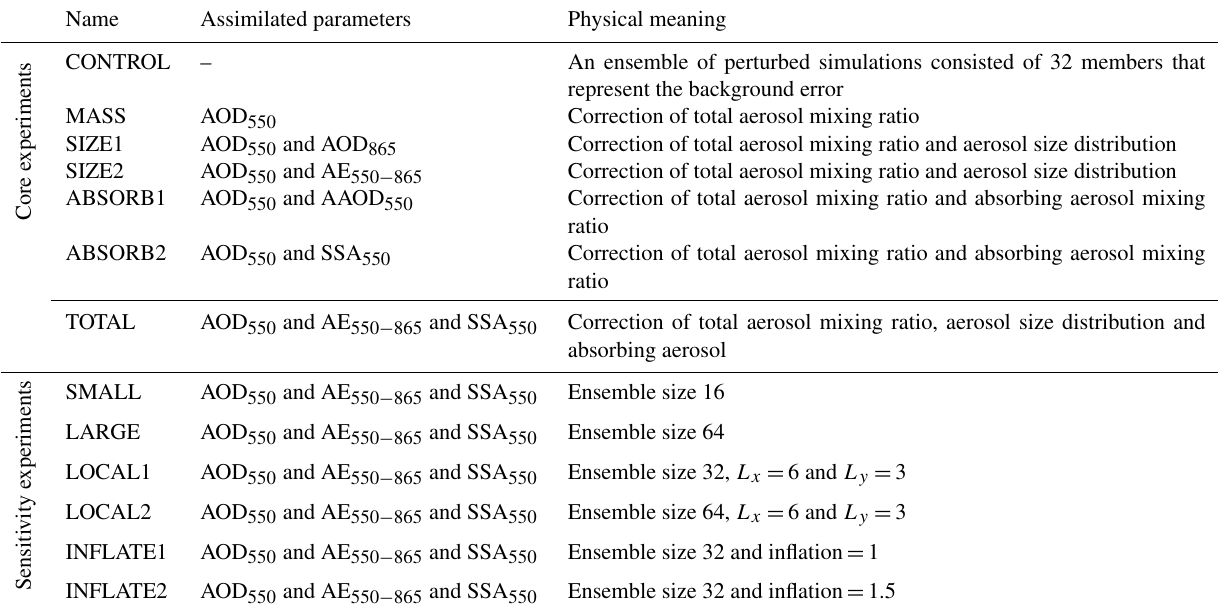
Table 2. The name along with the assimilated aerosol optical properties and the physical meaning of each experiment. All the assimilated parameters are retrievals of POLDER. All of the experiments used the rescaled emission factors of Sect.